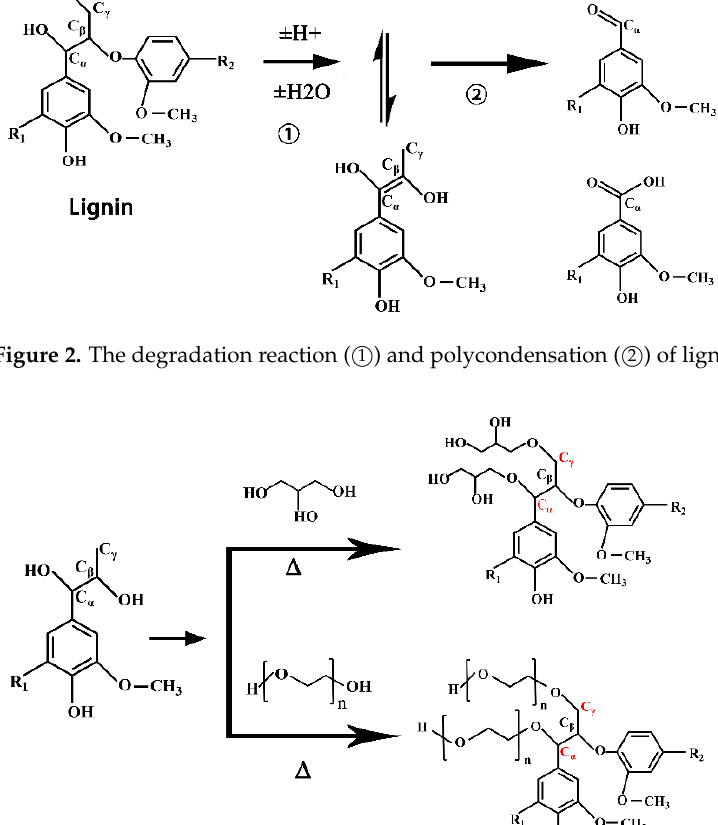
Figure 4. Condensation reaction between liquid solvents of polyols.